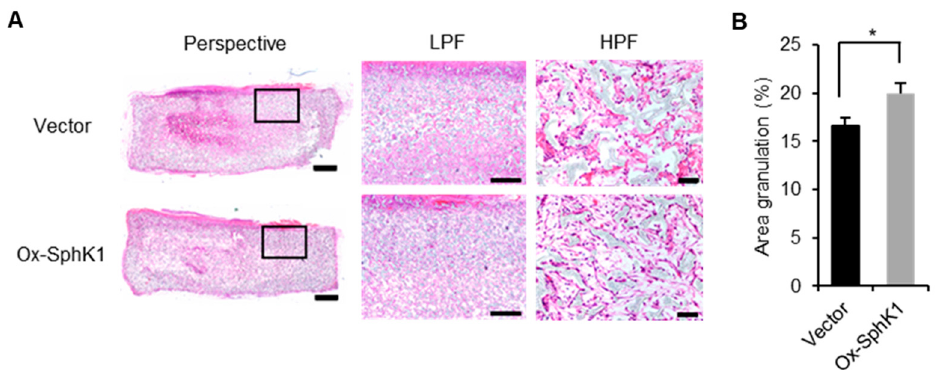
Figure 6. Topical SphK1 gene delivery promotes granulation. ( A ) Representative images of the hematoxylin and eosin (HE)-stained sponge granulomas treated with sCA-encapsulated plasmid injection on Day 14 are shown. The black boxes are shown magnified. (scale bars: Perspective: 1 mm; LPF: 400 µm; HPF: 50 µm). ( B ) Percentage of granulated area is graphed ( n = 8). All values in this figure represent the mean ± s.e.m. * p < 0.05.